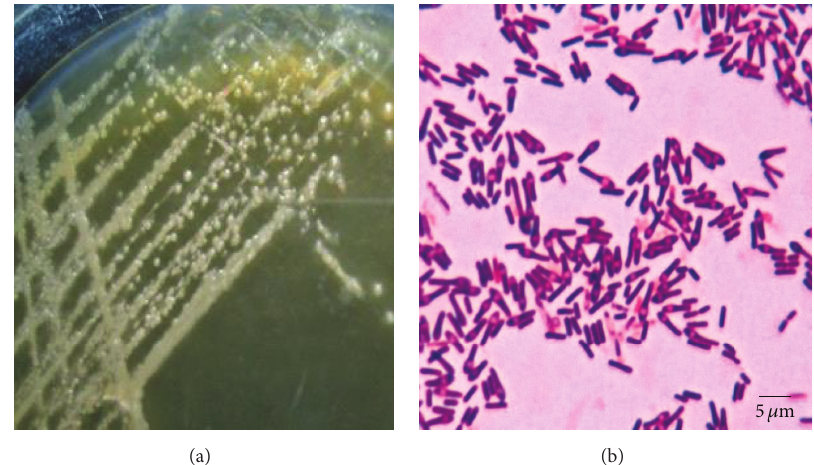
Figure 2: Morphology of colony (a) and cell (b) of B. sphaericus from Lombok Island in NYSM agar medium on 3 × 24-hour incubation.